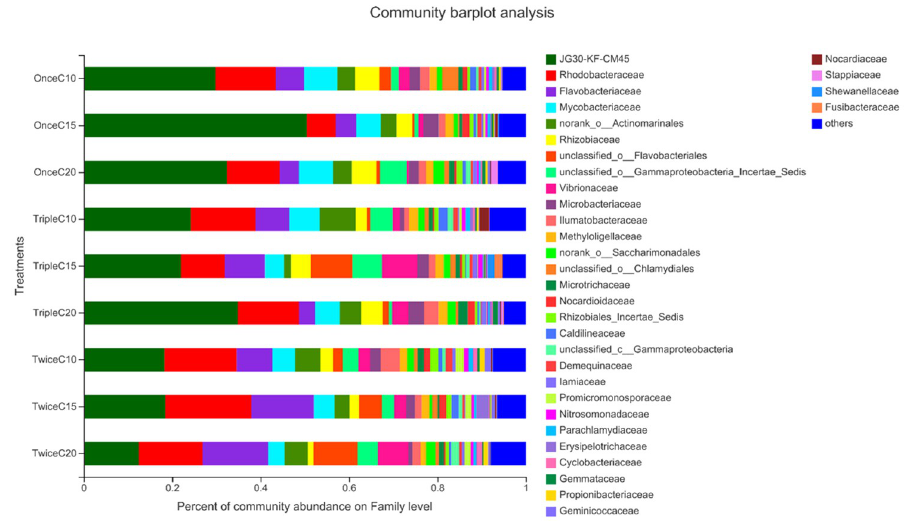
Fig 7. Relative abundance of the most prevalent bacterial family identified in the intestine of Litopenaeus vannamei reared in biofloc under different frequent addition times of carbon source (starch) (once, twice, triple) on daily basis and C/N ratios (10, 15, 20). T1; once C/N 10, T2; once C/N 15, T3; once C/N 20, T4; twice C/N 10, T5; twice C/N 15, T6; twice C/N 20, T7; triple C/N 10, T8; triple C/N 15, T9; triple C/N 20.